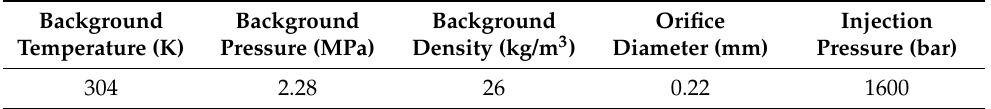
Table 6. Test to calibrate operating parameters.